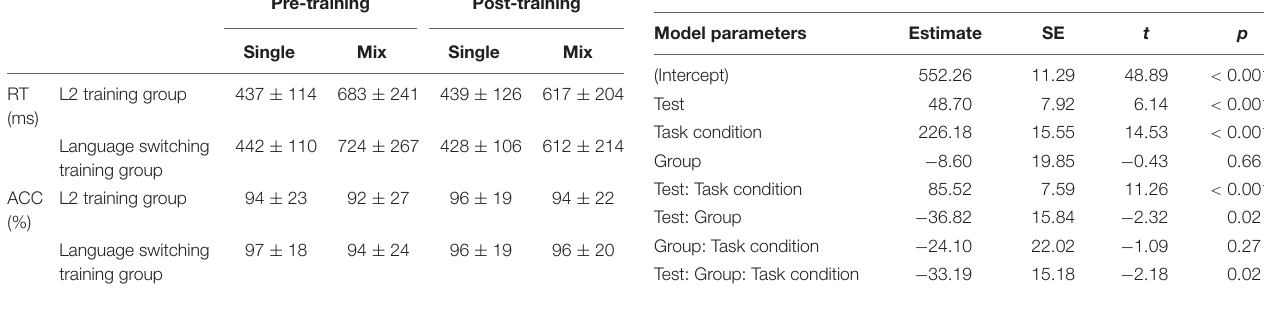
TABLE 8 | Model parameters for the best-fitting linear mixed effects model of the color-shape switching task in Experiment 2. Model